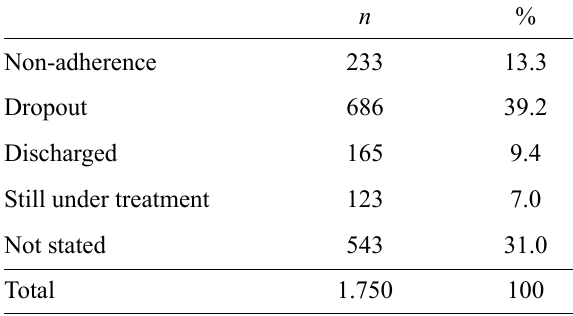
Distribution of the Sample as to How Psychotherapy